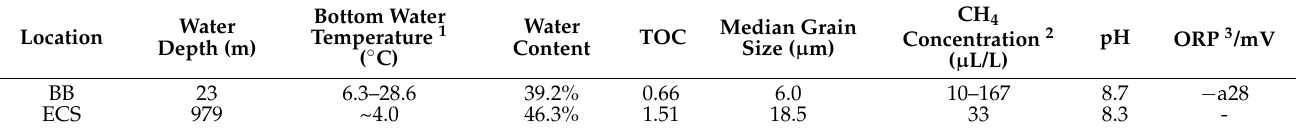
Table 1. Physical and chemical characteristics of the sediments used in this study.